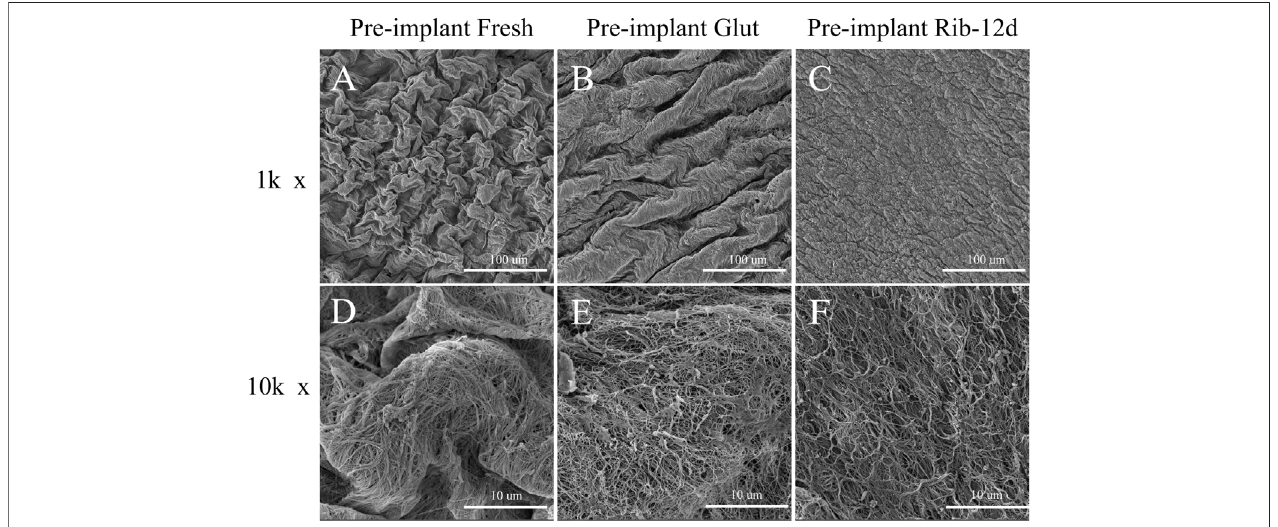
FIGURE4| SEMimagesofBPsurfacestructuresbeforeimplantation. (A,D) FreshBP. (B,E) Glut-treatedBP. (C,F) Rib-treatedBP.Scalebars:100 μ m (A – C) and 10 μ m (D – F) .